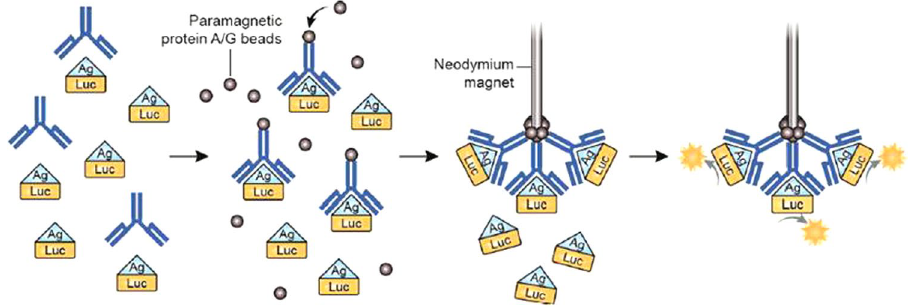
Figure 1. Overview of the LIPSTICKS assay. Only four simple steps are required for the 1 min antibody detection by LIPSTICKS: First, recombinant luciferase antigen fusion proteins are mixed together with diluted sera or saliva; second, paramagnetic protein A/G-coated beads are added, which bind antibody-antigen complexes; third, neodymium magnets collect the paramagnetic protein A/G-immune complexes and are briefly washed; and lastly, the magnet-bound immune complexes are placed into tubes containing luciferase substrate and emitted light is measured with a tube or hand-held